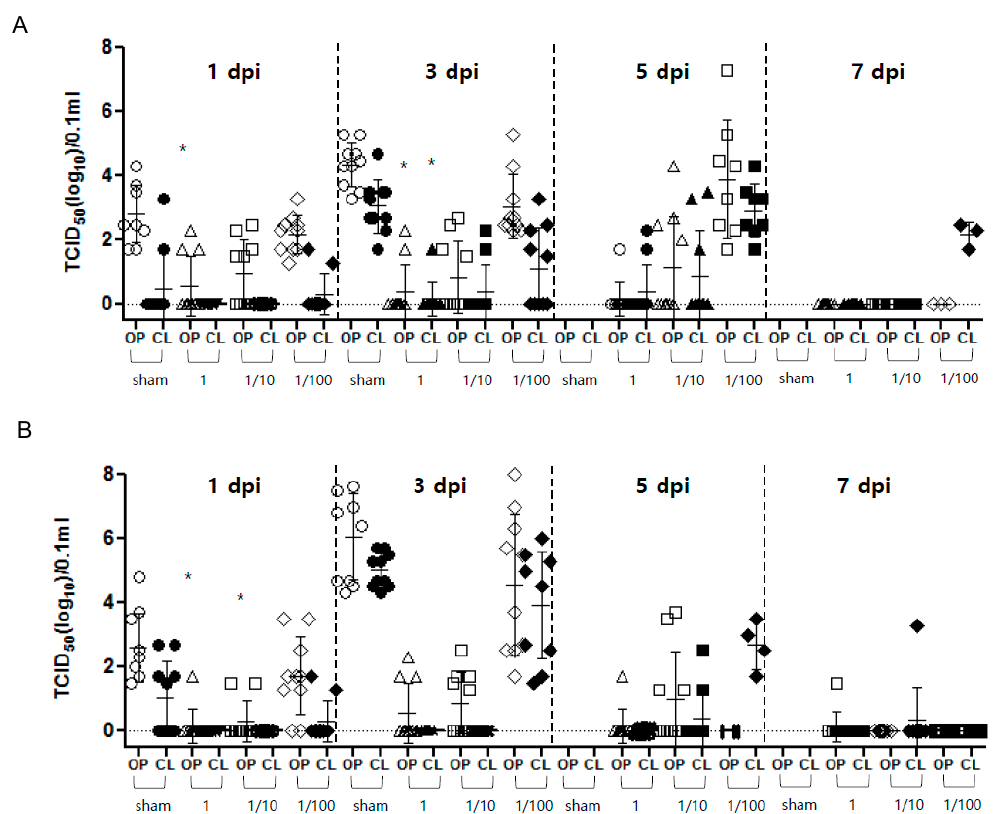
Figure 4. Shedding of virus in oropharyngeal and cloacal swabs taken from chickens inoculated with inactivated vaccines (full dose, 1/10 dose, 1/100 dose, or sham) was assessed at 1, 3, 5, and 7 days post-infection with highly pathogenic H5 viruses (Figure 4). Viral titers are expressed as log 10 TCID 50 (50% tissue culture infectious dose) per 0.1 mL, with error bars. ( A ) rgCA2/2.3.2.1d. ( B ) rgES3/2.3.4.4h. The lower limit of detection was 0.3 log 10 TCID 50 per 0.1 mL. * p value < 0.05.